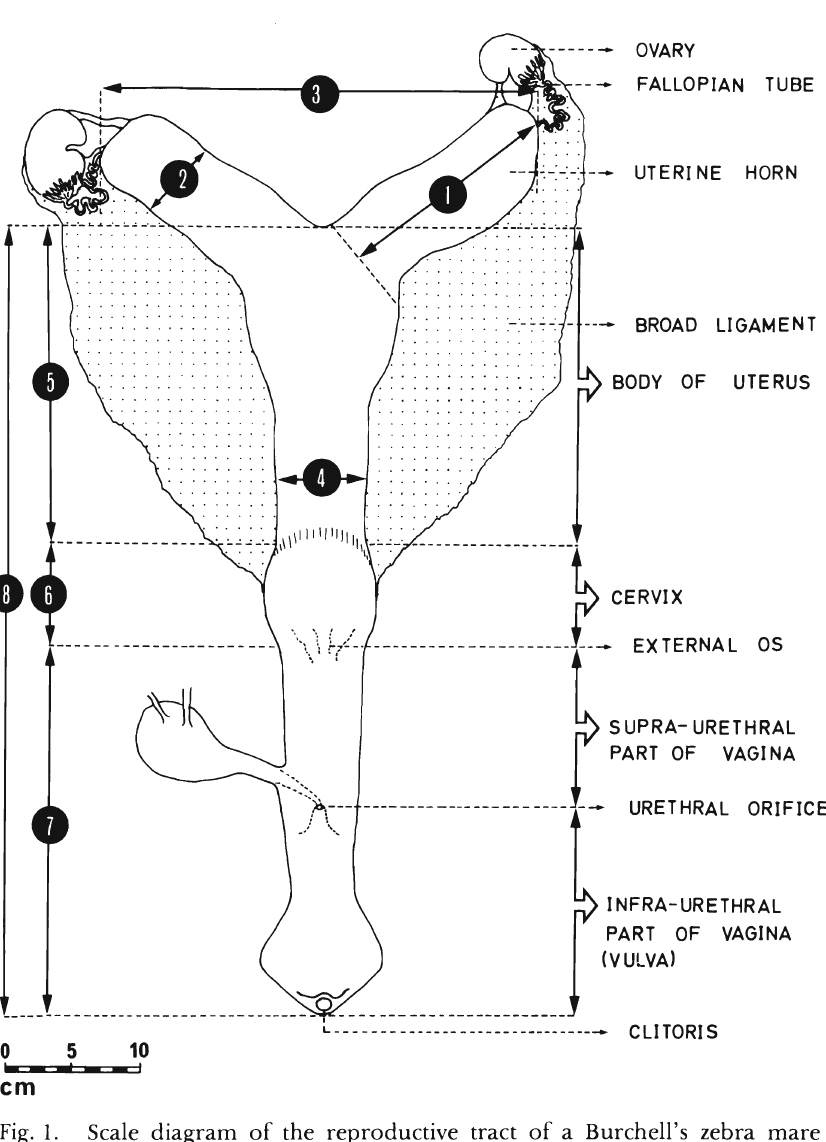
Fig. 1. Scale diagram of the reproductive tract of a Burchell's zebra mare illustrating the measurements (1 to 8) routinely made on the tracts of non-pregnant mares. These measurements were taken by laying the tract on a smooth, wet surface and allowing it to settle into